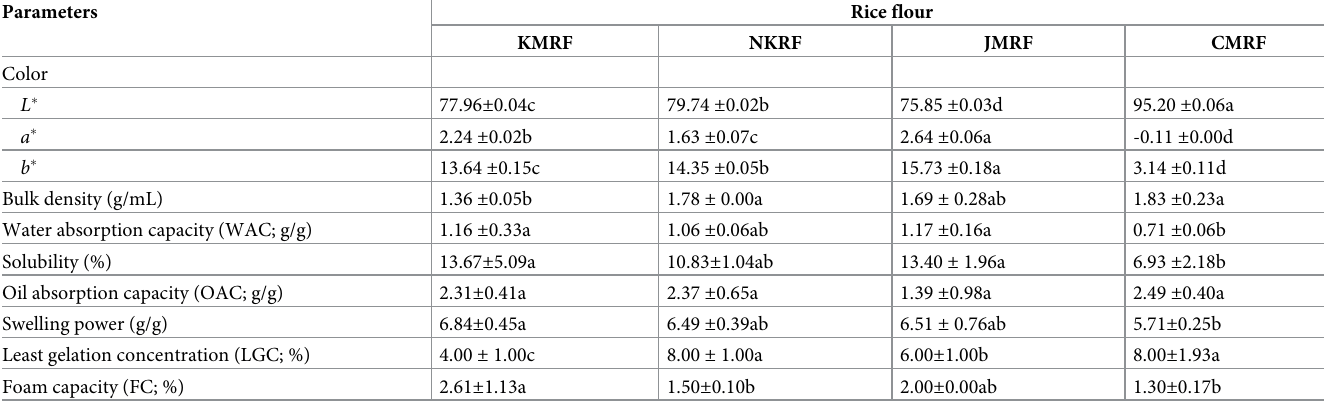
Values are means ± standard deviation from triplicate determinations. Different letters are significantly different along the rows ( p < 0.05). WAC, solubility, OAC, swelling power, LGC, and FC